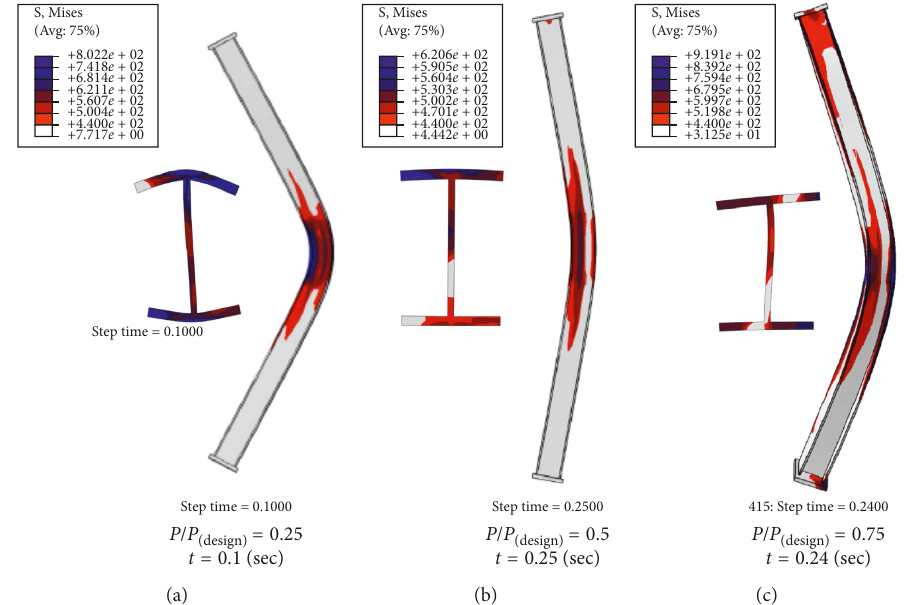
Figure 20: Deformation shape and plastic hinge locations of simply supported column W150